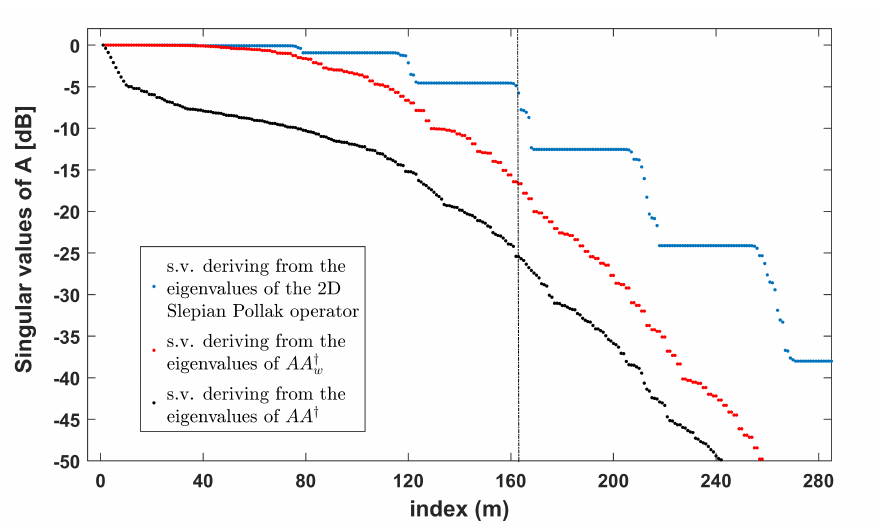
Figure 3. Singular values of A , and their approximation.